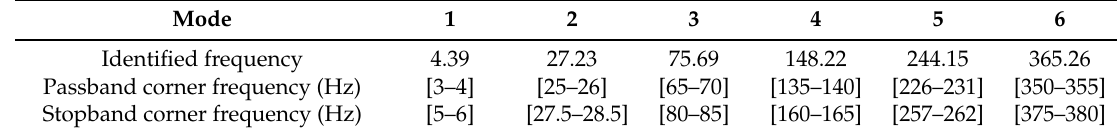
Table 4. Frequency ranges for each band-pass filters for the experiment.